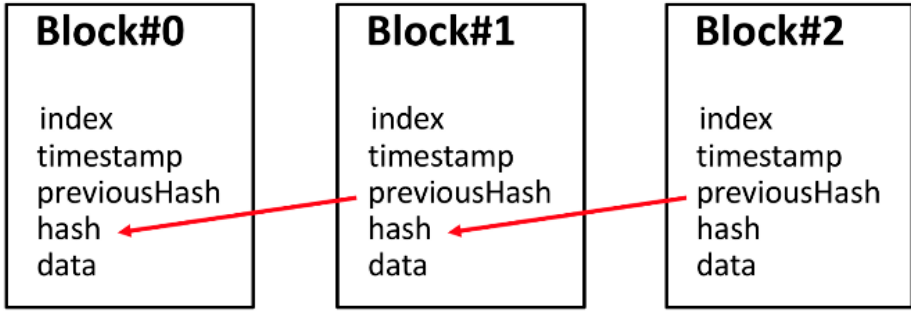
Figure 1. The components and basic architecture of the blockchain.